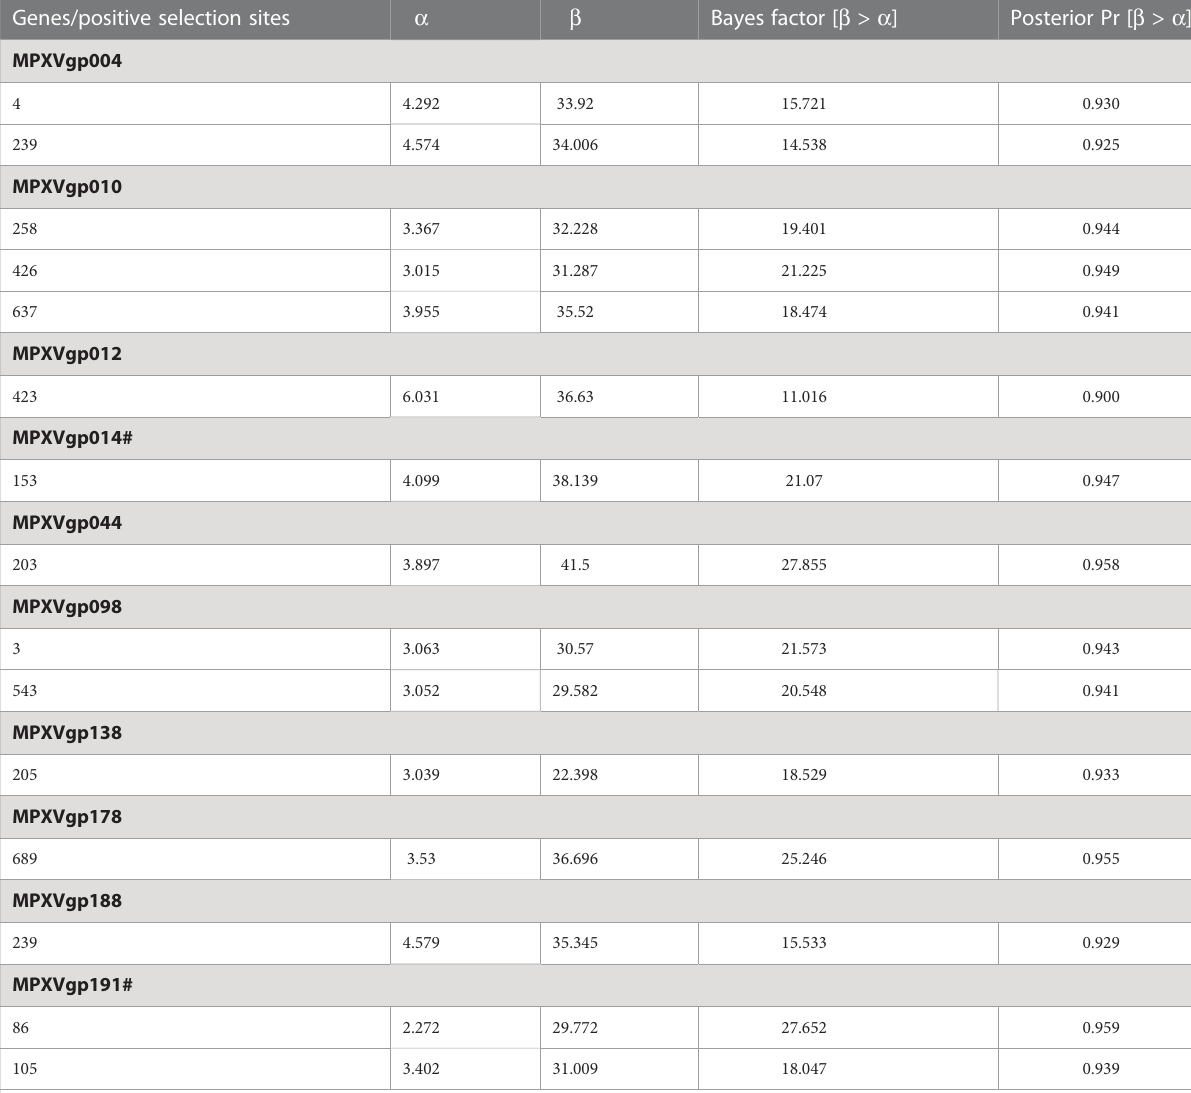
TABLE 3 Parameter estimates for protein-coding genes of monkeypox virus and positive selection sites detected by Fast Unconstrained Bayesian Approximation methods implemented in the HyPhy package. Genes/positive selection sites a b Bayes factor [ b > a